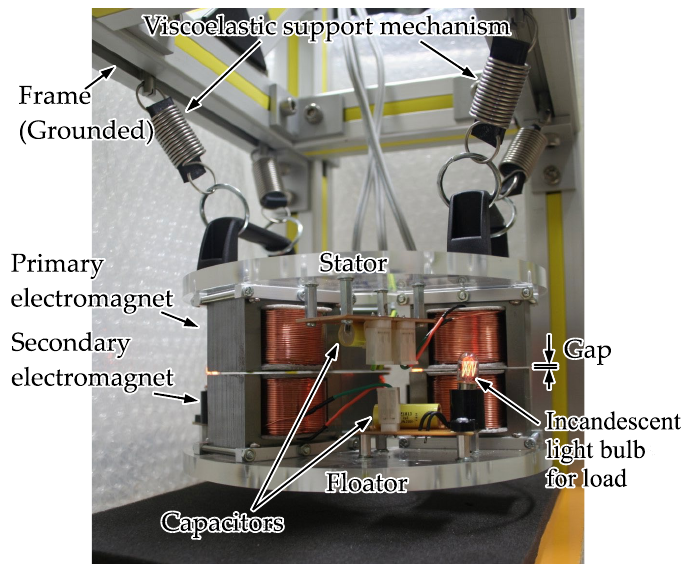
Figure 10. Photograph of an AC magnetic suspension system using magnetic resonant coupling. The photograph is an enlargement of the main part when the floator levitates steadily. The floating gap is approximately 0.4 mm. Incandescent light bulbs are used for power consumption. The lighting of the incandescent light bulbs demonstrates power transmitting to the floator.